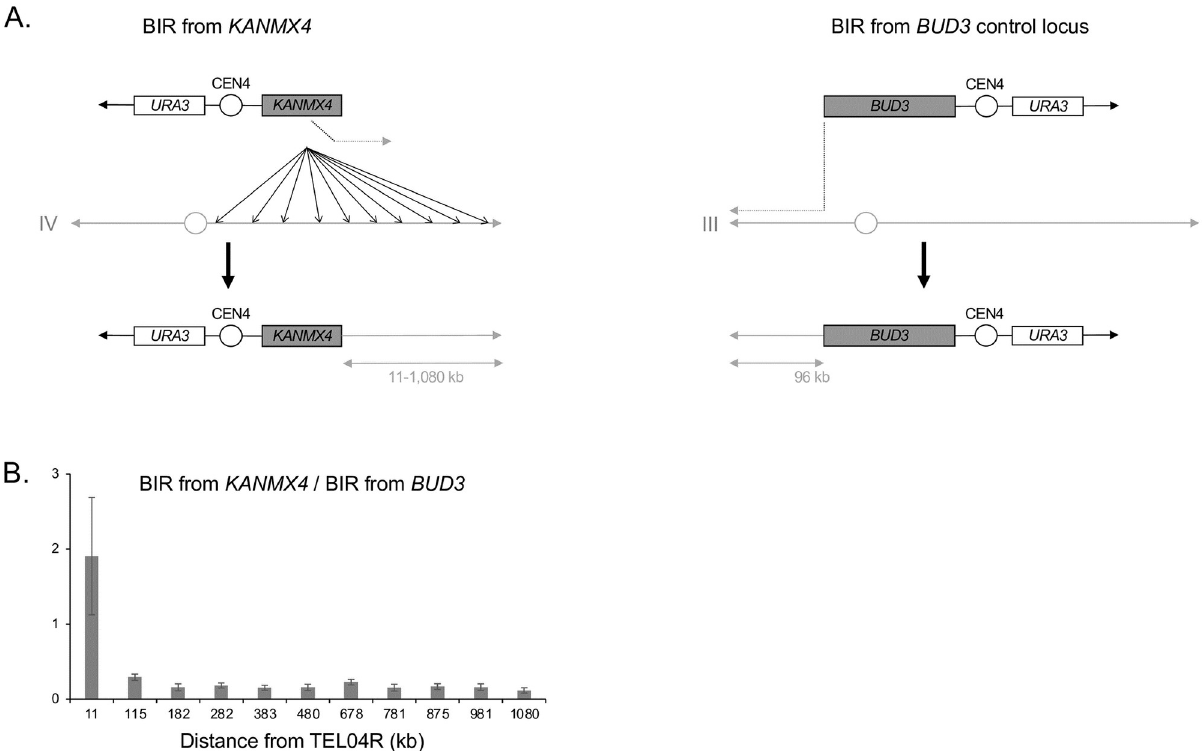
Fig 1. Ectopic BIR efficiency along the right arm of chromosome IV. A . The BIR assay used in this study is based on the transformation into yeast cells of a linearized chromosome fragmentation vector (CFV). This CFV contains a telomere seed (black arrowhead), the URA3 auxotrophic marker, the centromere from chromosome IV (CEN4) and a region of homology with the genome to initiate BIR ( KANMX4 or BUD3 ). This CFV being deprived of any origin of replication, the only way it can be maintained into the cell is after undergoing BIR to incorporate an origin of replication from the chromosome as well as a telomere to be stabilized. The number of transformants obtained using the linearized plasmid reflects BIR efficiency. Left : the region of homology with the genome is the KANMX4 selection cassette. This cassette has been used to systematically replace individually all the S . cerevisiae ORFs keeping the same orientation of transcription as the endogenous ORFs [31]. Right : the region of homology with the genome encompasses BUD3 . B . Ratio between the efficiencies of BIR initiated from the KANMX4 selection cassette from different loci along the right arm of chromosome IV and the efficiency of BIR initiated from BUD3 . Mean ratios of five (1,080; 981; 875; 11), four (781; 678; 383; 282; 182) and three (480; 115) independent experiments are shown. Error bars represent standard deviation.